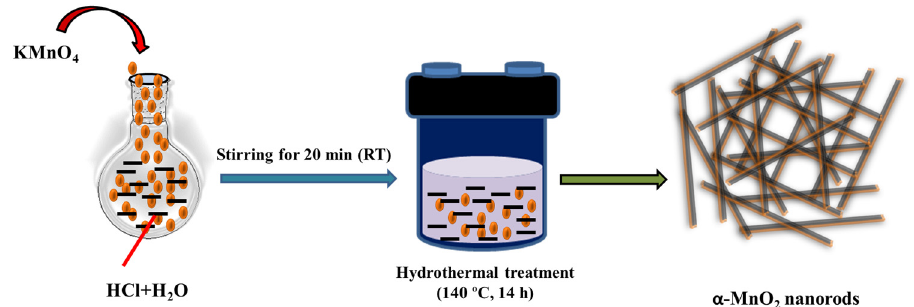
Scheme 1. Pictorial representation for synthesis of α -MnO 2